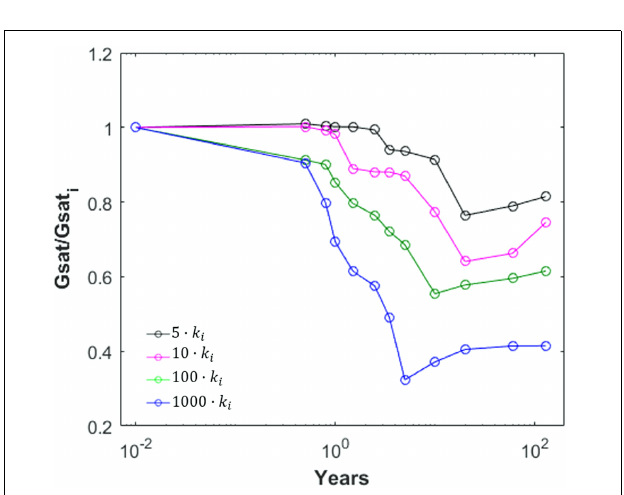
FIGURE 13 | Time variation of the mean gas saturation related to Scenario II in the central upwelling zone (black dashed ellipse in Figure 3 ) normalized to its initial value for four different increases of the initial permeability values, k i